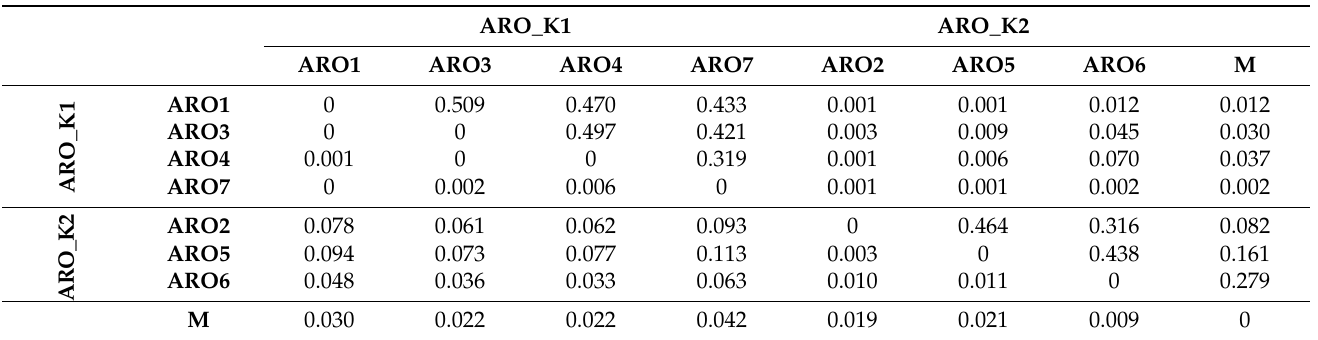
Table 1. Pairwise Population F ST values (below diagonal). Probability, P (rand ≥ data) based on 999 permutations, is shown above diagonal.